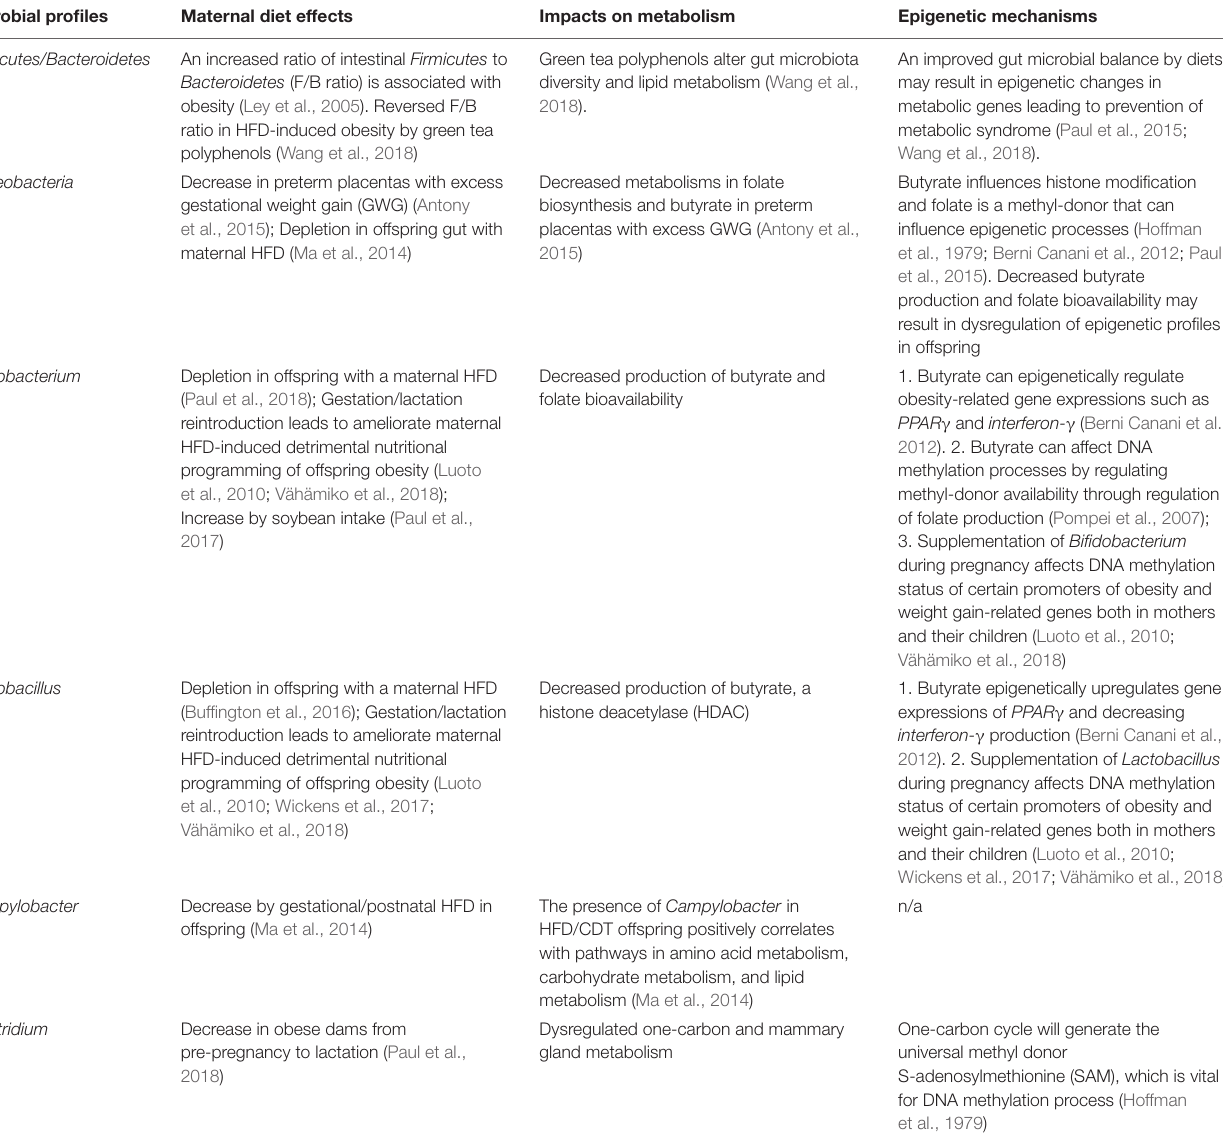
TABLE 2 | Specific profiles of gut microbiota in regulation of maternal diets-induced obesity in the